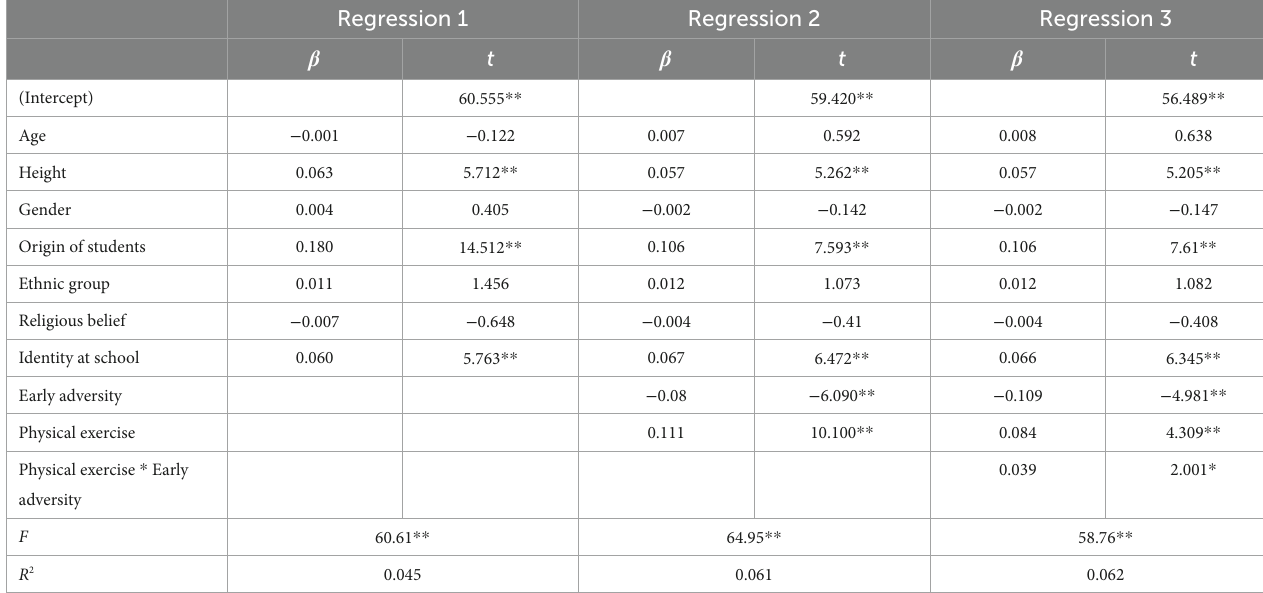
TABLE 3 Linear regression analyses of mental